Question: Give a one-sentence summary of this figure.
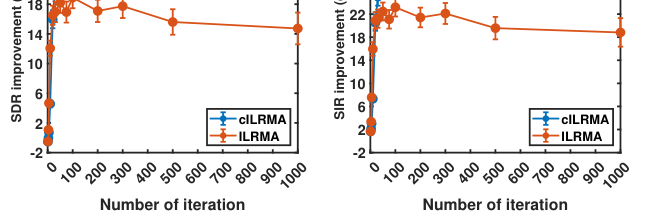
Answer: Average SDR and SIR improvements versus iteration number. Conditions: source signals are from two female speakers in WSJ0 and there is no reverberation.